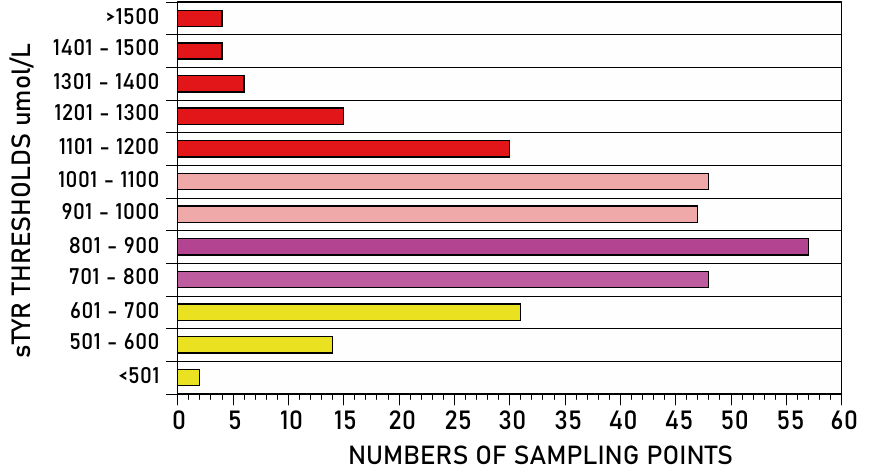
Figure 1. Distribution of sTYR concentrations between V2 and V6 in NIT-treated patients. The colour coding indicates numbers of sampling points below sTYR < 701 (yellow), 701–900 (violet), 901–1100 (pink) and > 1100 (red) µmol/L.